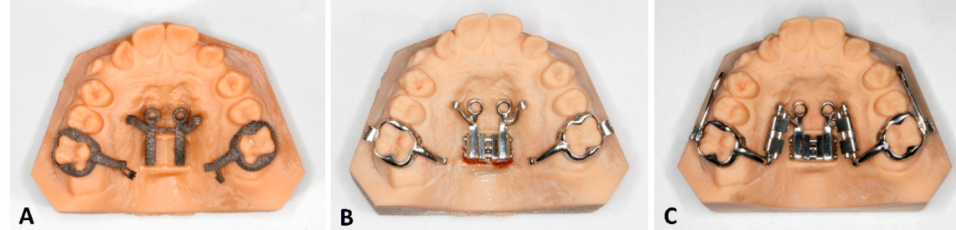
Figure 6. Post-processing of a 3D-printed appliance. ( A ) Unprocessed printed parts, ( B ) surface milled and polished, Jack screw and tubes welded to the appliance, ( C ) completed appliance for molar distalization and simultaneous face mask wear